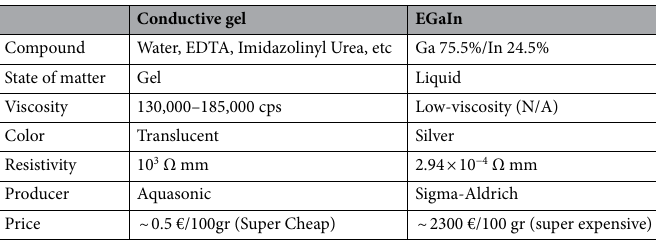
Table 1. Comparison between characteristics of EGaIn and conductive